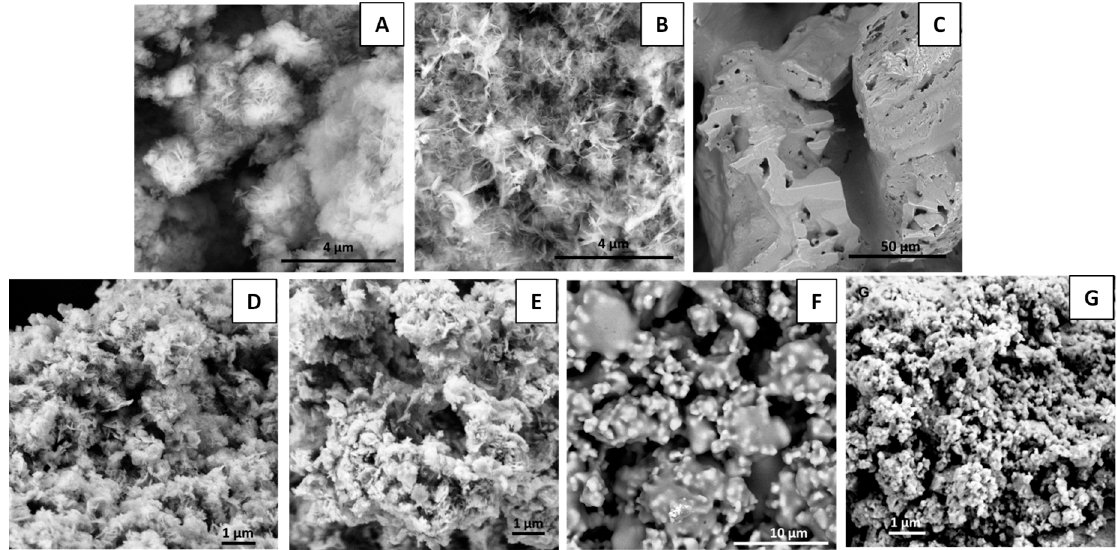
Figure 4. SEM images of MgAl LDH ( A ); MgFe LDH ( B ); K 2 HPO 4 ( C ); MgAl 200 ( D ); MgFe 200 ( E ); MgAl 200 /K 2 HPO 4 ( F ); and MgFe 200 /K 2 HPO 4 ( G ).